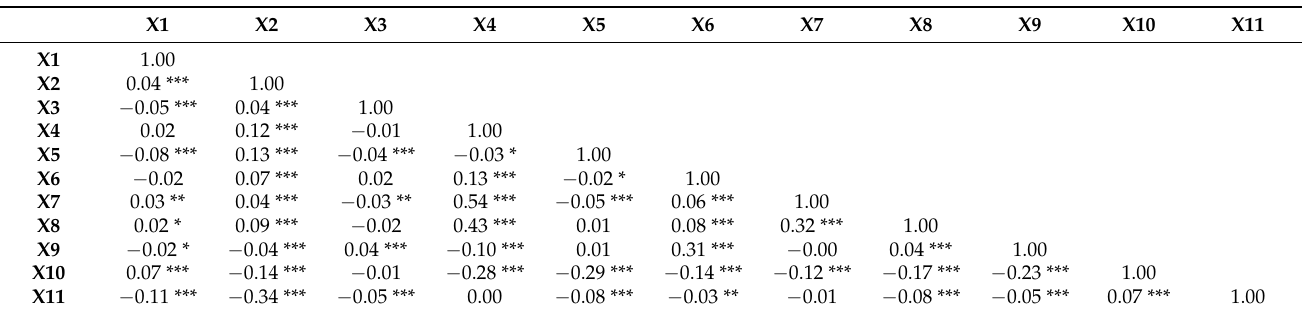
Table 2. Correlation analysis (N =